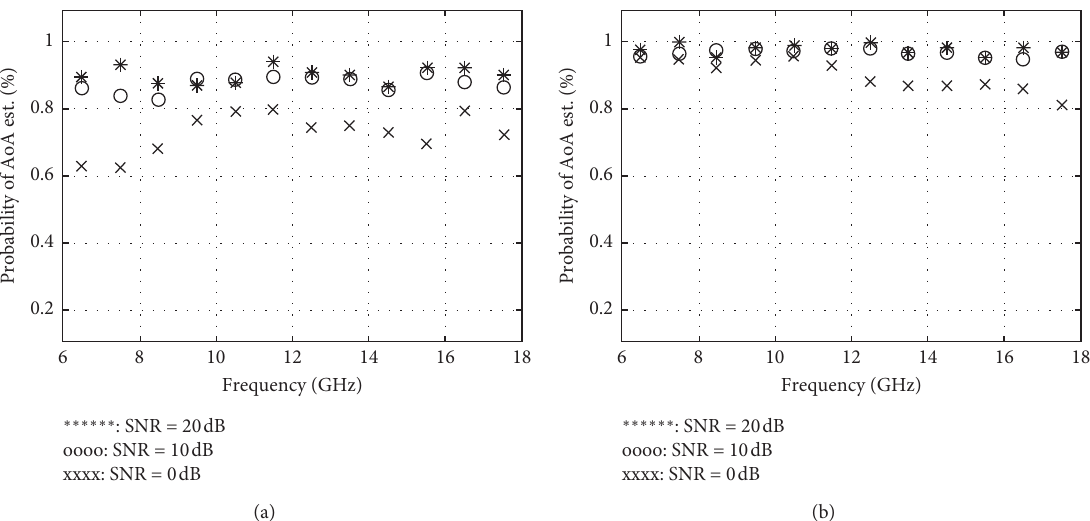
Figure 24: Frequency vs probability of AoA estimation for Array-3 and WF-1 with 512 snapshots: (a) RMSE ≤ 1 ° and (b) RMSE ≤ 5 °